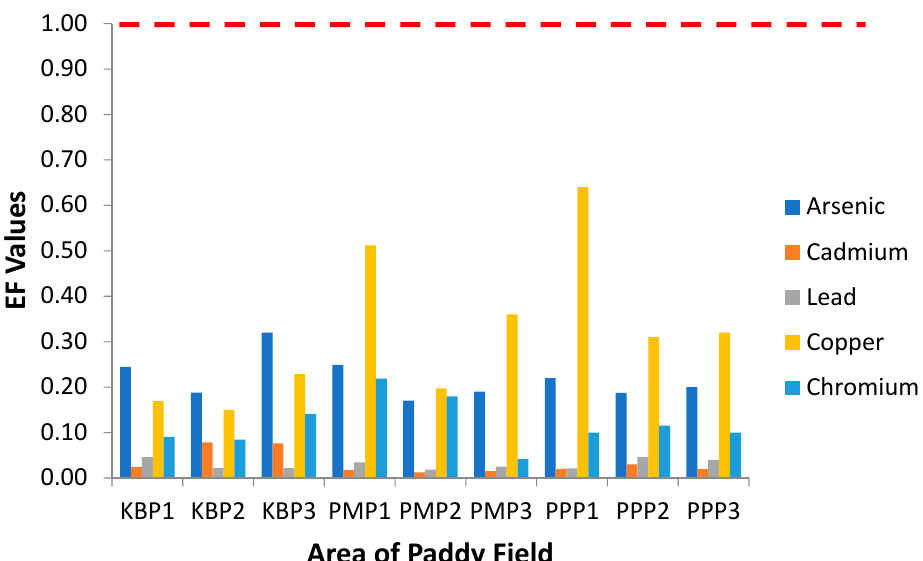
Figure 2. Enrichment factor (EF) of the heavy metals in the different sampling sites. KBP1: Kota Bharu Plot 1, KBP2: Kota Bharu Plot 2, KBP3: Kota Bharu Plot 3, PMP1: Pasir Mas Plot 1, PMP2: Pasir Mas Plot 2, PMP3: Pasir Mas Plot 3, PPP1: Pasir Puteh Plot 1, PPP2: Pasir Puteh Plot 2, and PPP3: Pasir Puteh Plot 3.